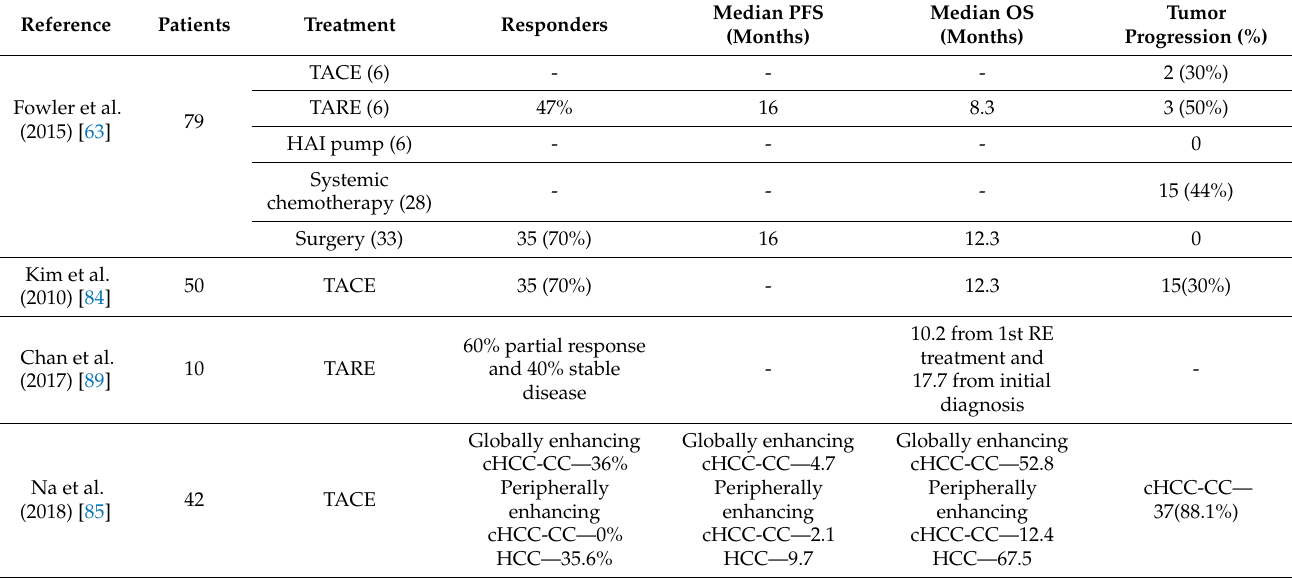
Table 2. Summary of studies on the use of locoregional therapy for combined hepatocellular cholangiocarcinoma. Reference Patients